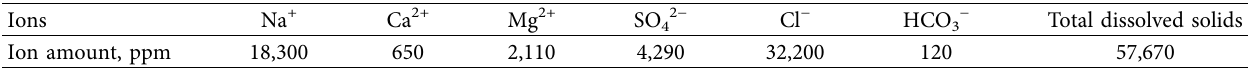
Table 1: Ion contents in